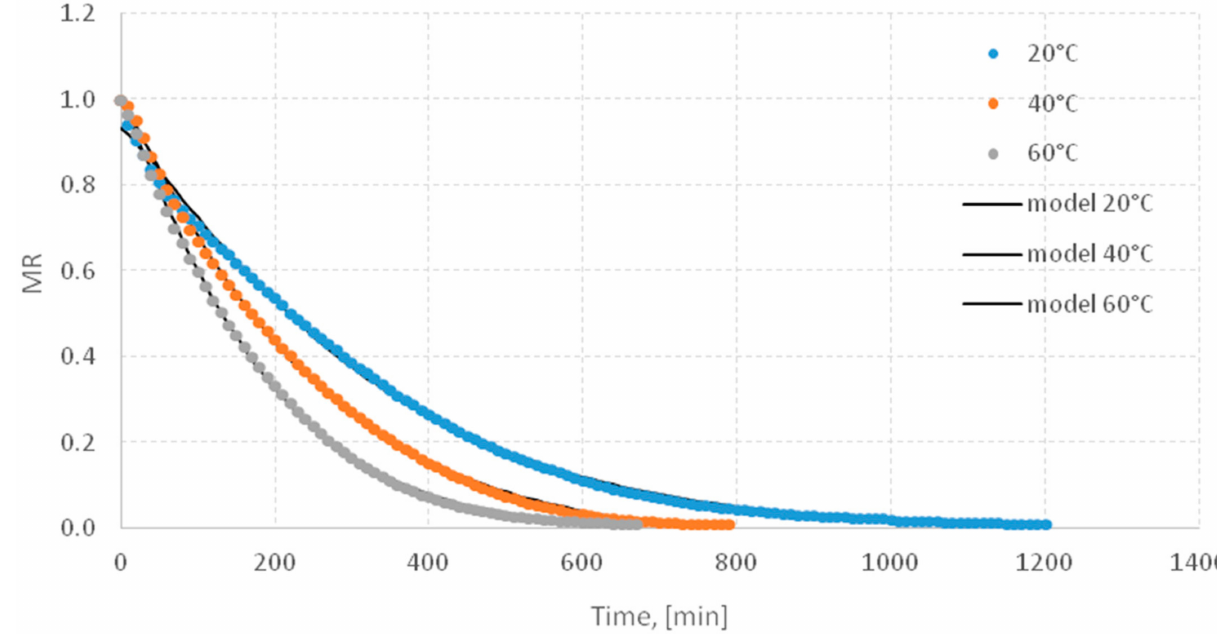
Figure 1. Drying curves of freeze-drying of strawberry slices, MR —moisture ratio.